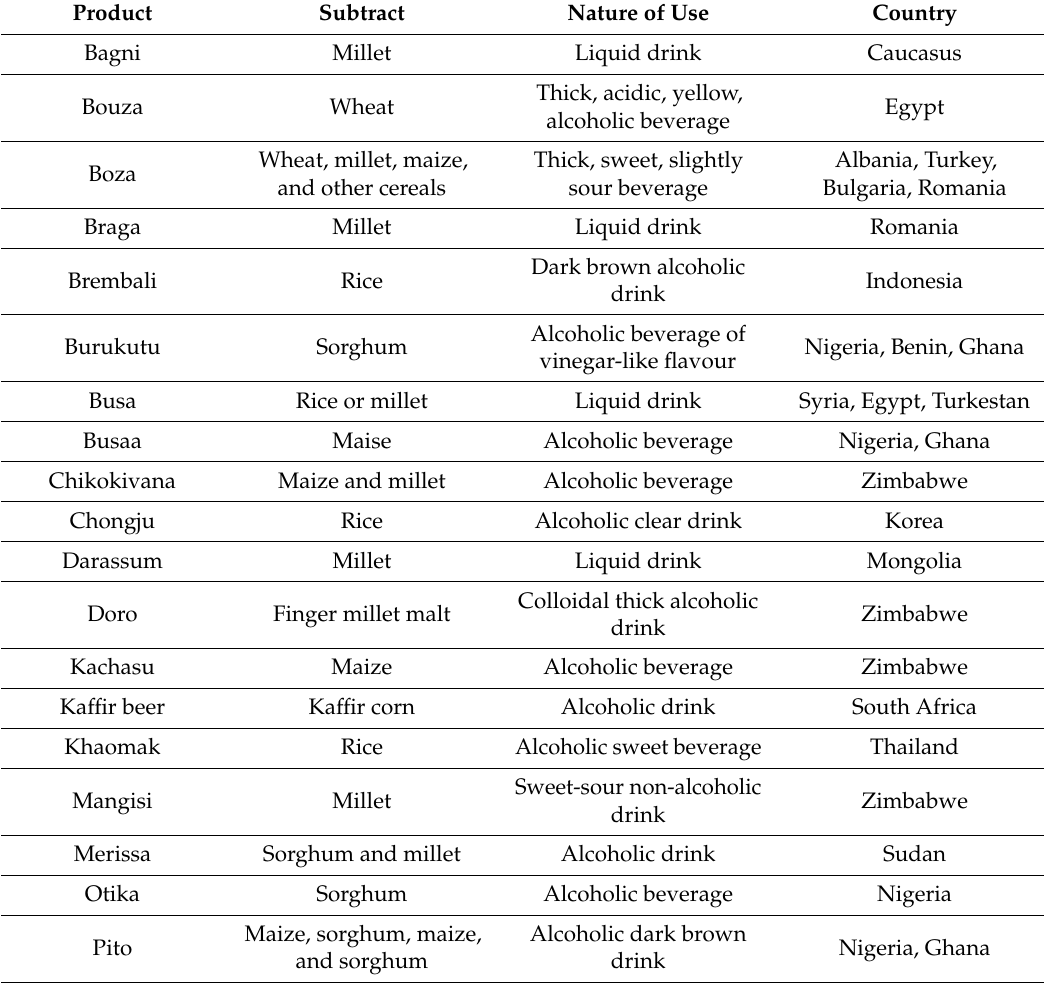
Table 2. Cereal fermented beverages. Adapted from Blandino et al. [131].